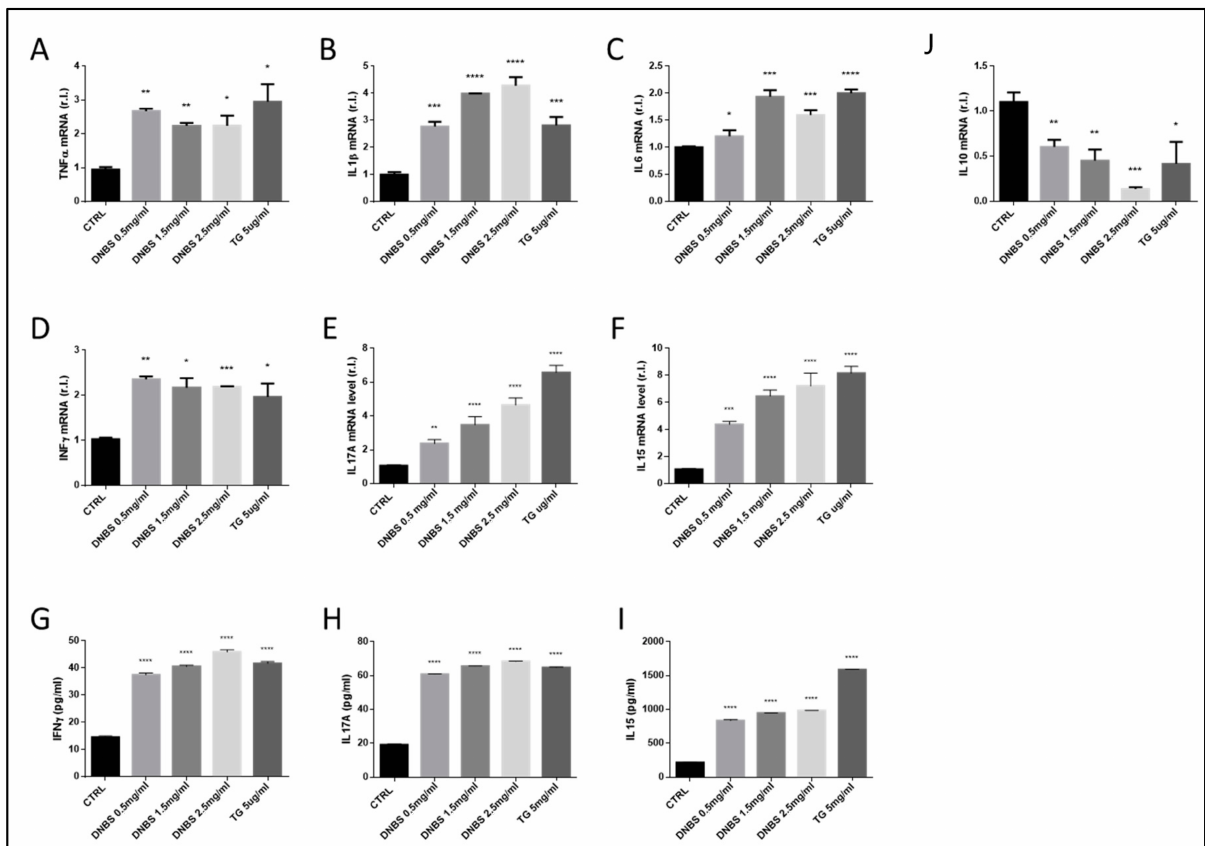
Figure 3. DNBS-modulated IBD-related cytokines expression. Colon tissues were cultivated 5 h as in Figure 2 and the expression of the pro-inflammatory cytokines TNF α ( A ), IL-1 β ( B ), IL-6 ( C ), IFN γ ( D ), IL17A ( E ), and IL15 ( F ) was evaluated at mRNA level, by qPCR. The production of IFN γ ( G ), IL17A ( H ), and IL15 ( I ) were also evaluated at the protein level, by ELISA. The expression of the anti-inflammatory cytokine IL10 was also evaluated in the same experimental conditions, by qPCR ( J ). Each panel is representative of experiments performed in triplicate. Histograms represent mean ± SD of triplicate sample; **** p < 0.0001; *** p < 0.001; ** p < 0.01; * p <